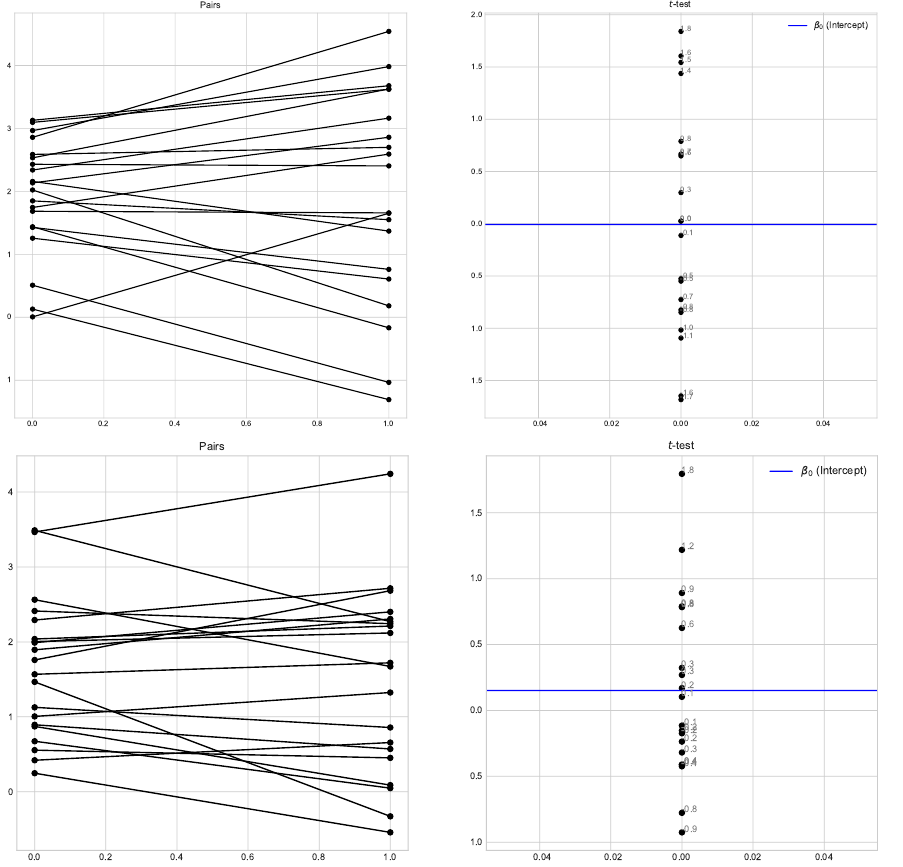
Figure 15. TDPP: Pairs Wilcoxon plots for total time usage and total memory usage for ϕ 1 , ϕ 2 , and ϕ 3